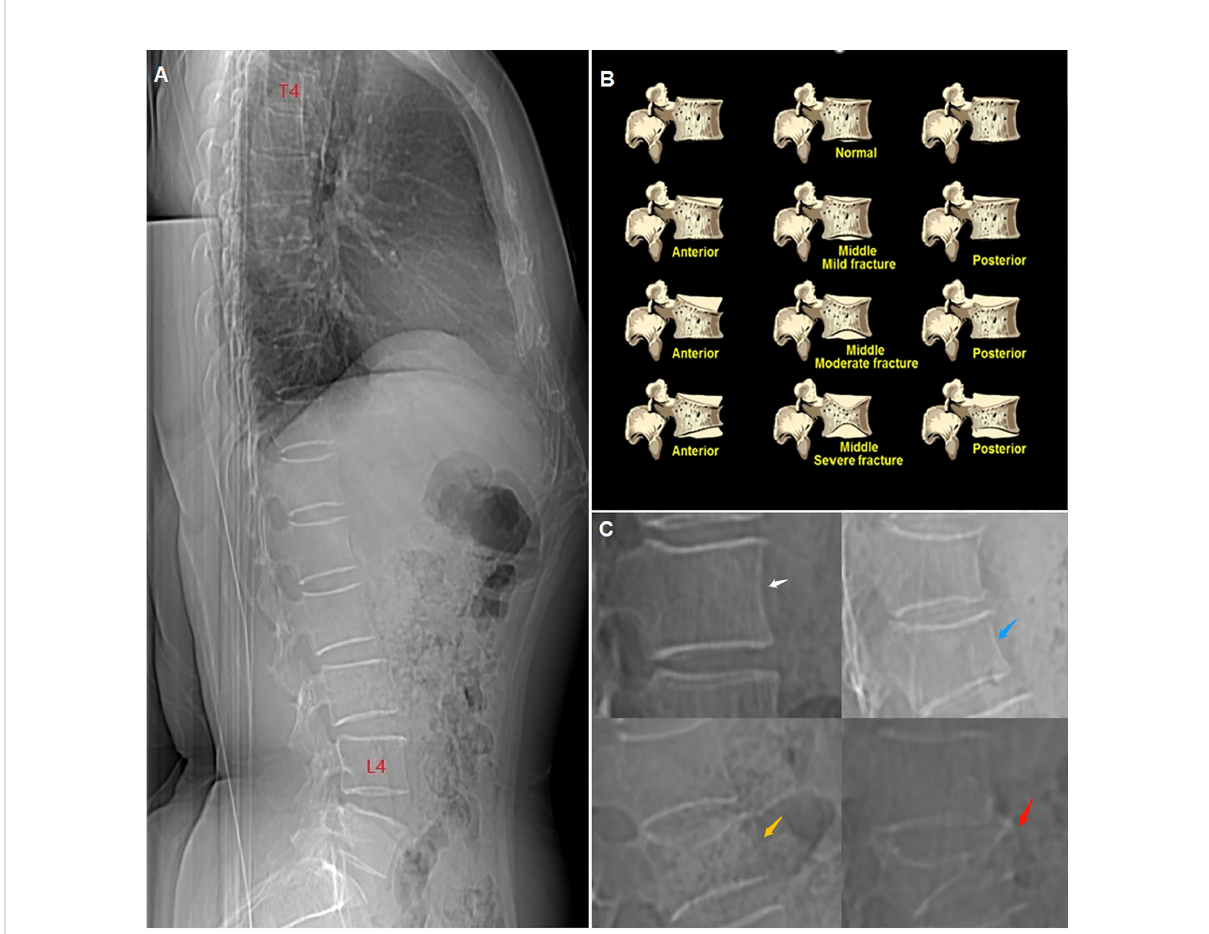
FIGURE 1 (A) CT lateral scout view of the vertebrae from T4 to L4. (B) schematic diagram of Genant ’ s semiquantitative (GSQ) method. (C) compression degree of vertebrae showed in CT lateral scout view, white arrow: non-fractured (grade 0), blue arrow: mild (grade 1), yellow arrow: moderate (grade 2), red arrow: severe (grade